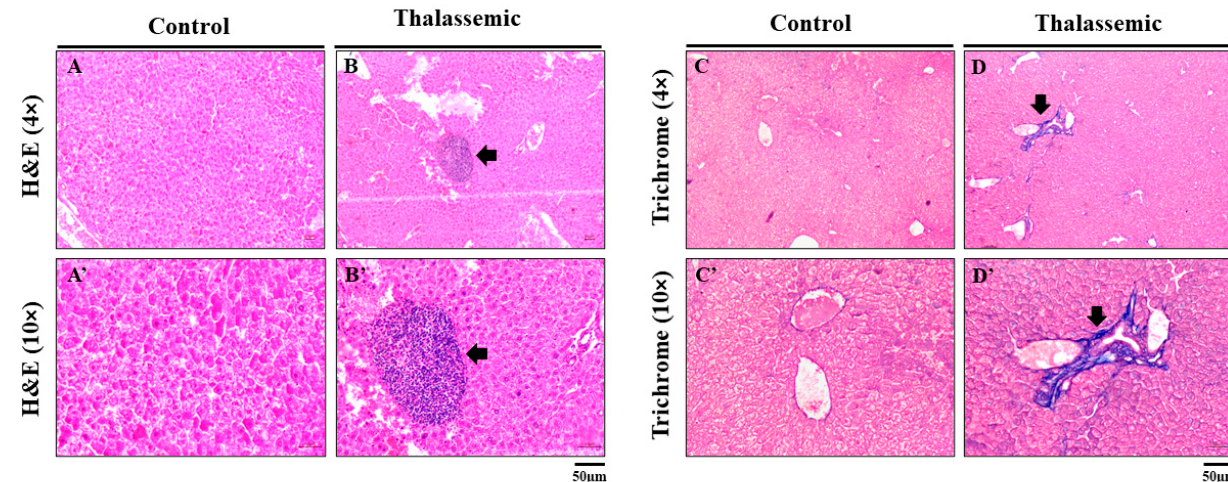
Figure 6. Representative images of H&E-stained liver tissue sections in control mice ( A , A’ ) and thalassemic mice ( B , B’ ), and Masson trichrome-stained liver tissue sections in control mice ( C , C’ ) and Hbb th3/+ mice ( D , D’ ) at 4 × and 10 × , respectively ( n = 4). Black arrow represents the inflammatory foci and collagen deposition. Scale bar represents 50 µ m.